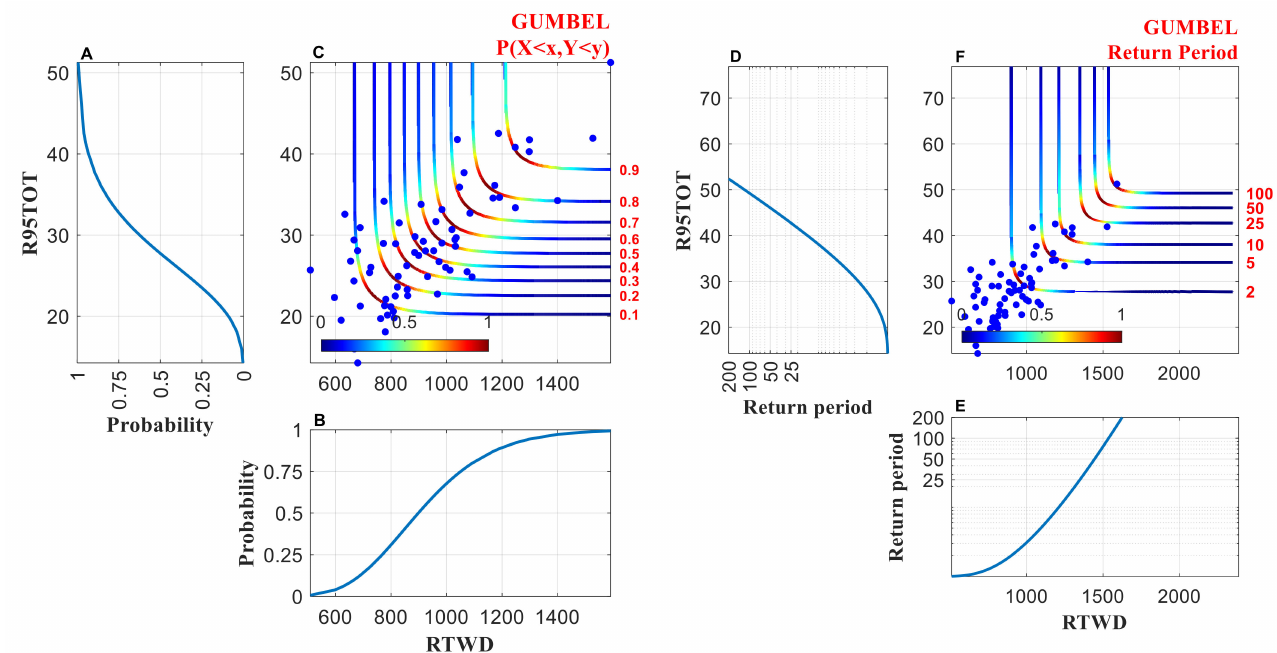
Figure 8. Cumulative distributive functions of ( A ) R95TOT and ( B ) RTWD, and their ( D ) and ( E ) are associated univariate periods ( y -axis indicated in log scale). Joint probability iso lines derived from the Gumbell copula are displayed in Figure ( C ), and the associated return period isolines are illustrated in Figure ( F ). The colorbar [0 1] represents the joint density levels of joint probability and return periods, where 0 represents lower and one represents higher density level. Blue dots represent the observed pairs of R95TOT and RTWD. The figure is plotted using the MvCAT toolbox [51] in MATLAB (Version 9.4 R